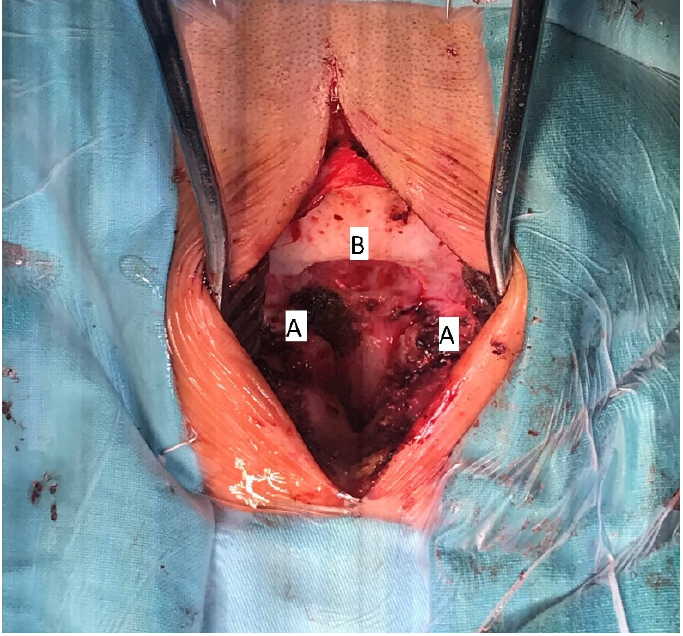
Figure 4. Intraoperative image of decompressive craniotomy ( B ); bifid arch of the atlas ( A ), 15 years of age.